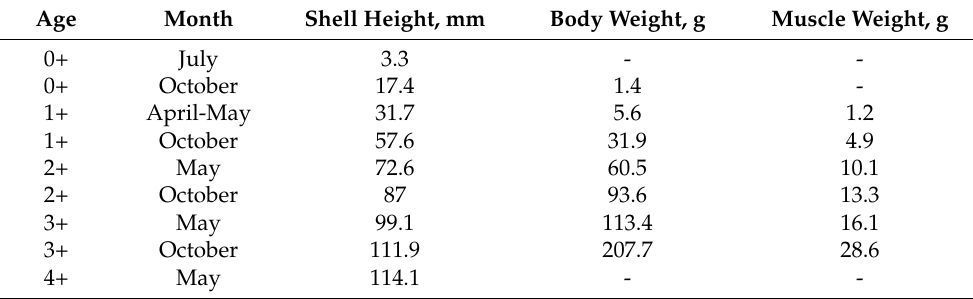
Table 3. Size and weight of Mizuhopecten yessoensis cultivated in suspended cages in the Sea of Japan [78]. Age Month Shell Height, mm Body Weight, g Muscle Weight,